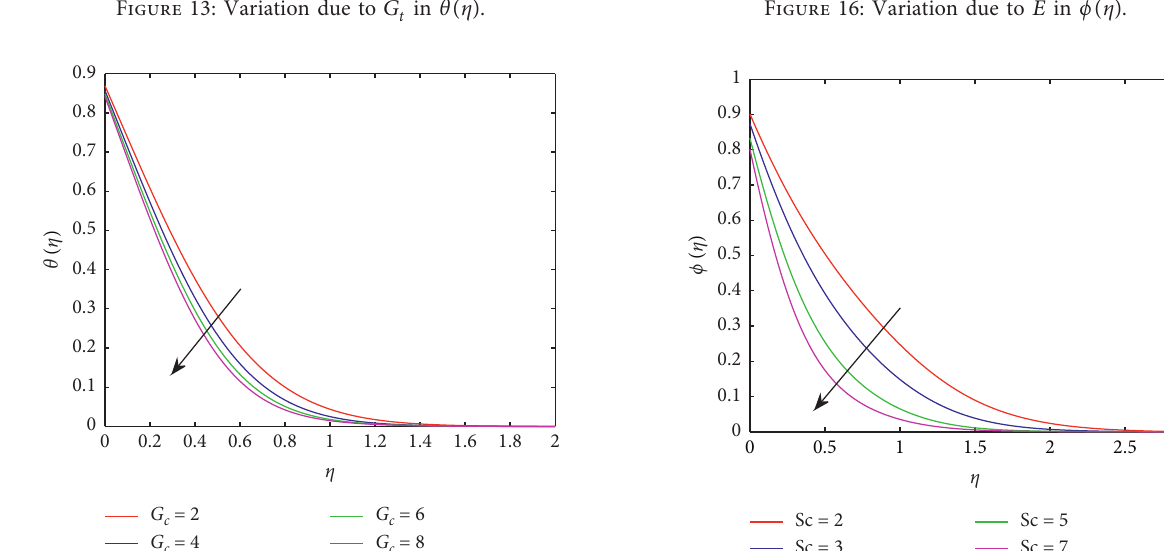
Figure 17: Variation due to Sc in ϕ ( η )